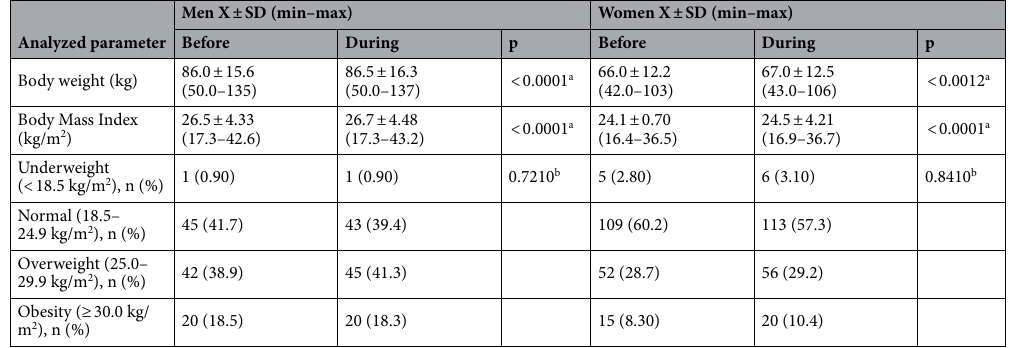
Table 2. Anthropometric characteristics of the studied groups of men and women, including differences before and during SARS-CoV-2 (n = 312). X average, SD standard deviation, n number of participants. a The Wilcoxon test. b McNemar-Bowker test.